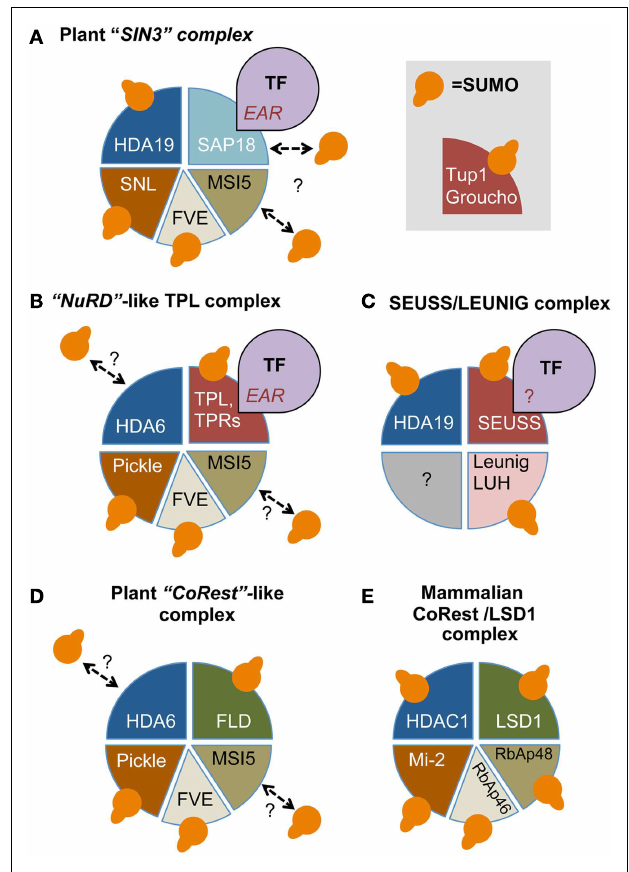
FIGURE 2 | Sumoylation impacts transcription repressor complexes conserved between mammals, yeast, and plants. (A) The heavily sumoylated SIN3 co-repressor complex contains next to SNLs, AtSAP18, a class I histone deacetylase, e.g . , HDA6/HDA19, and the histone-chaperones FVE and MSI5. Subunits for which sumoylation was established are indicated. (B) Likewise, the NuRD-like co-repressor complex contains – instead of SIN3/SAP18 – the SUMO targets Pickle (PKL; the plant homolog of the mammalian Mi-2) and the co-adaptorTopless (TPL) or its homologs (TPRs).TheTPL/TPRs and SAP18 are both recruited to DNA-bound transcription factors (TFs) by EAR motifs present in theseTFs. The homologs ofTPL in other eukaryotes (Groucho/TUP1-like) are also sumoylated. (C) Another sumoylated repressor complex consists of the co-adaptors SEUSS and LEUNIG (LUG).The peptide motif involved in recruiting this complex is unknown (“?”). (D) Finally, the CoRest/LSD1-like complex that contains in addition the lysine demethylase Flowering locus D (FLD) is also sumoylated at several subunits.The mammalian homologs of the CoRest subunits are indicated in (E). For further details on the role of SUMO in the different complexes we refer to the main